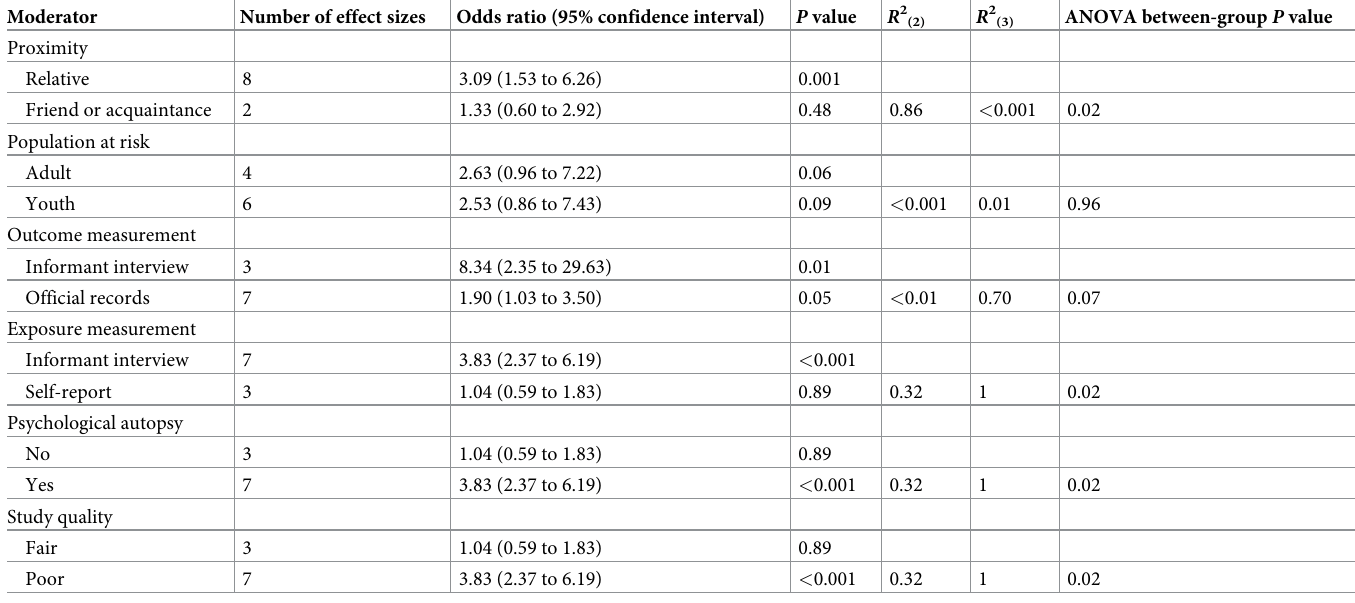
Table 4. Results of moderator analyses of exposure to suicidal behavior (composite measure—suicide or suicide attempt) across suicide, suicide attempt, and sui- cidal ideation